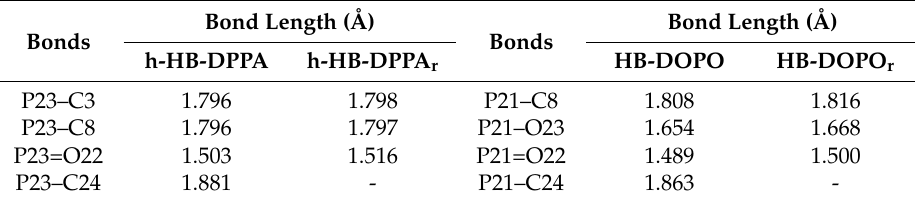
Figure 7. Optimized molecular structure of HB-DPPA and HB-DOPO moieties. Table 4. Calculated bond lengths of HB-DPPA and HB-DOPO moieties.